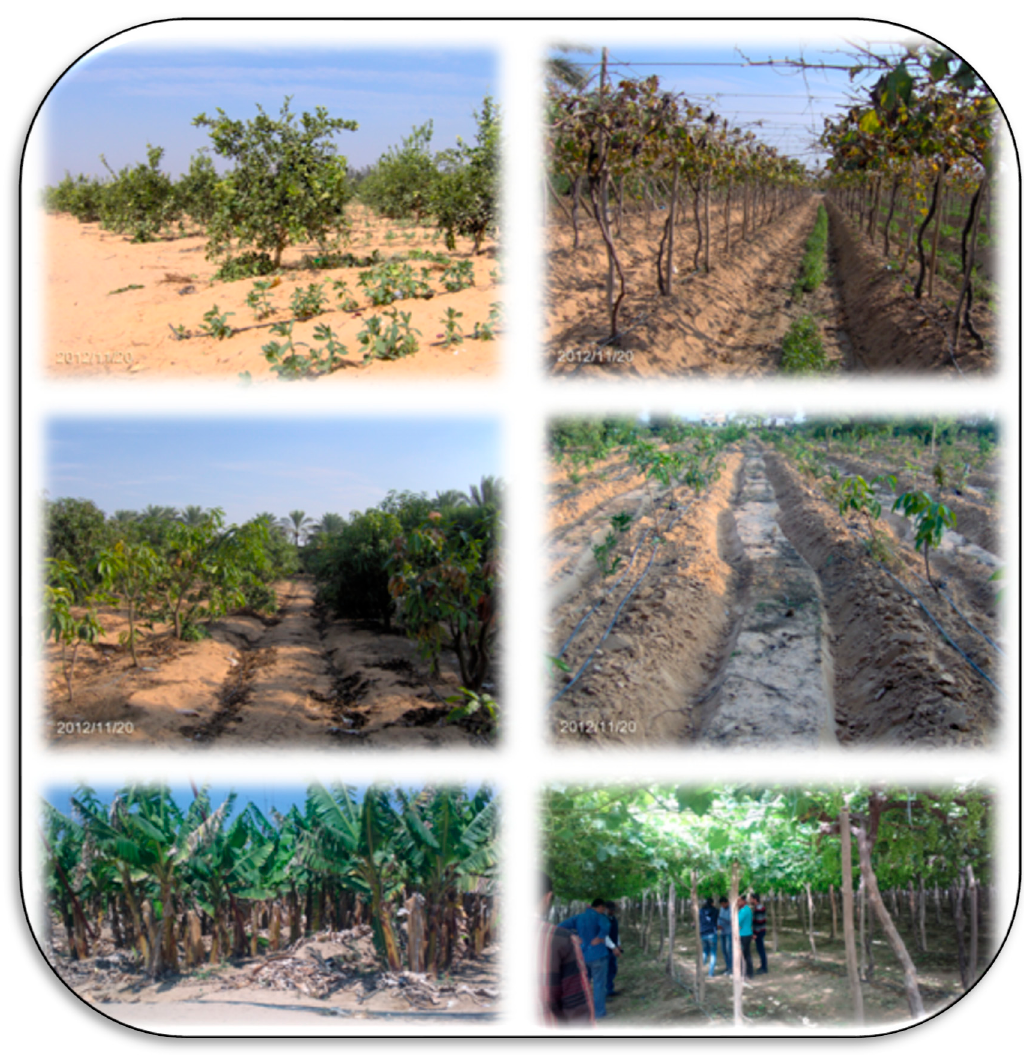
Figure 4. Cultivation of sandy soils is a great challenge facing the arid and semi-arid regions because of low fertility and low ability to hold water. These photos represent cultivation of sandy soil with different horticultural crops in Egypt, including citrus, grapes ( higher photo left from saline sandy and right), mango ( middle photos, which represent saline sandy soils), and banana ( lower photo left). Photos by